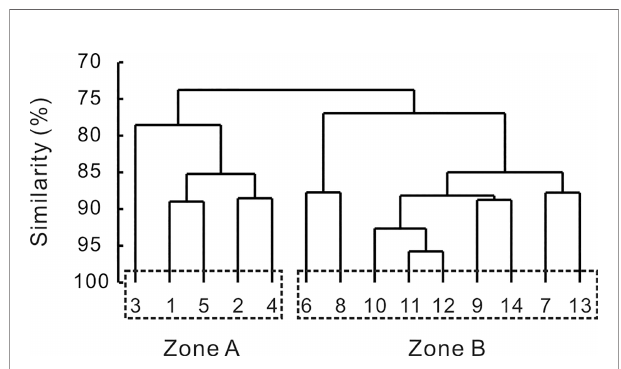
FIGURE 3 | Dendrograms generated by cluster analysis with Bray-Curtis distance representing the spatial distribution pattern of gobiid larvae assemblage